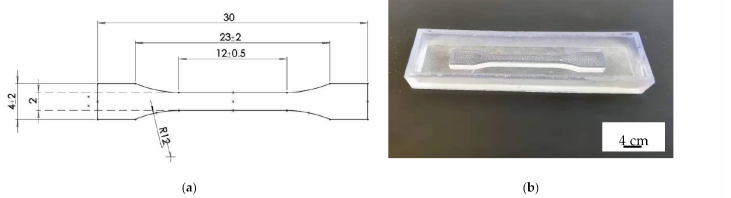
Figure 1. The casting mold of ( a ) the 1BB type geometry of tensile bar and ( b ) the male casting mold made by